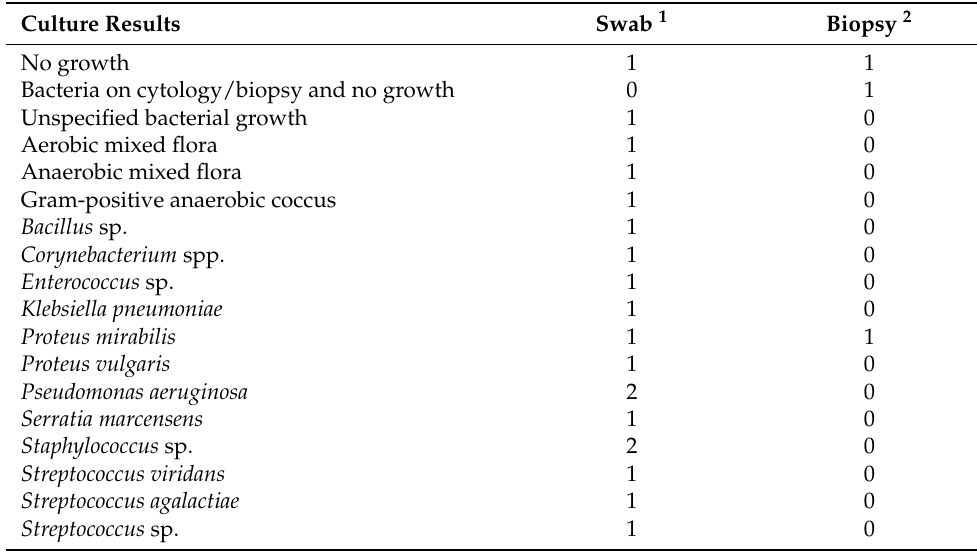
Table 5. Initial bacterial culture results from culture swabs and/or biopsies of exposed pulp tissue from Class III